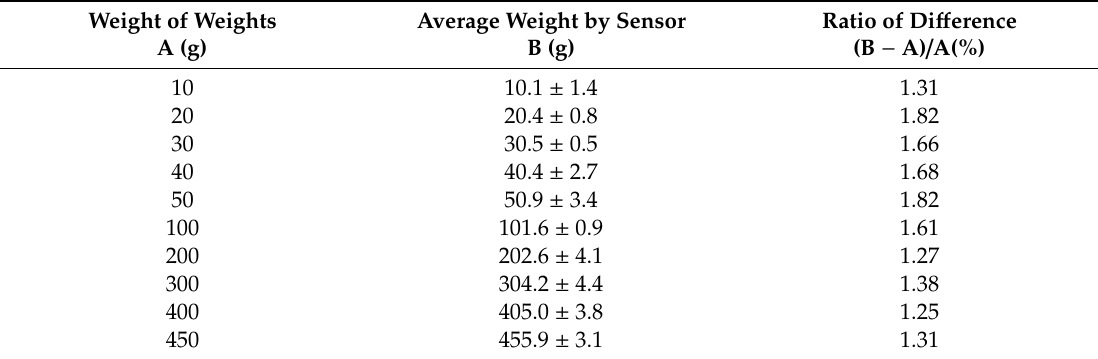
Table 3. Parameter of